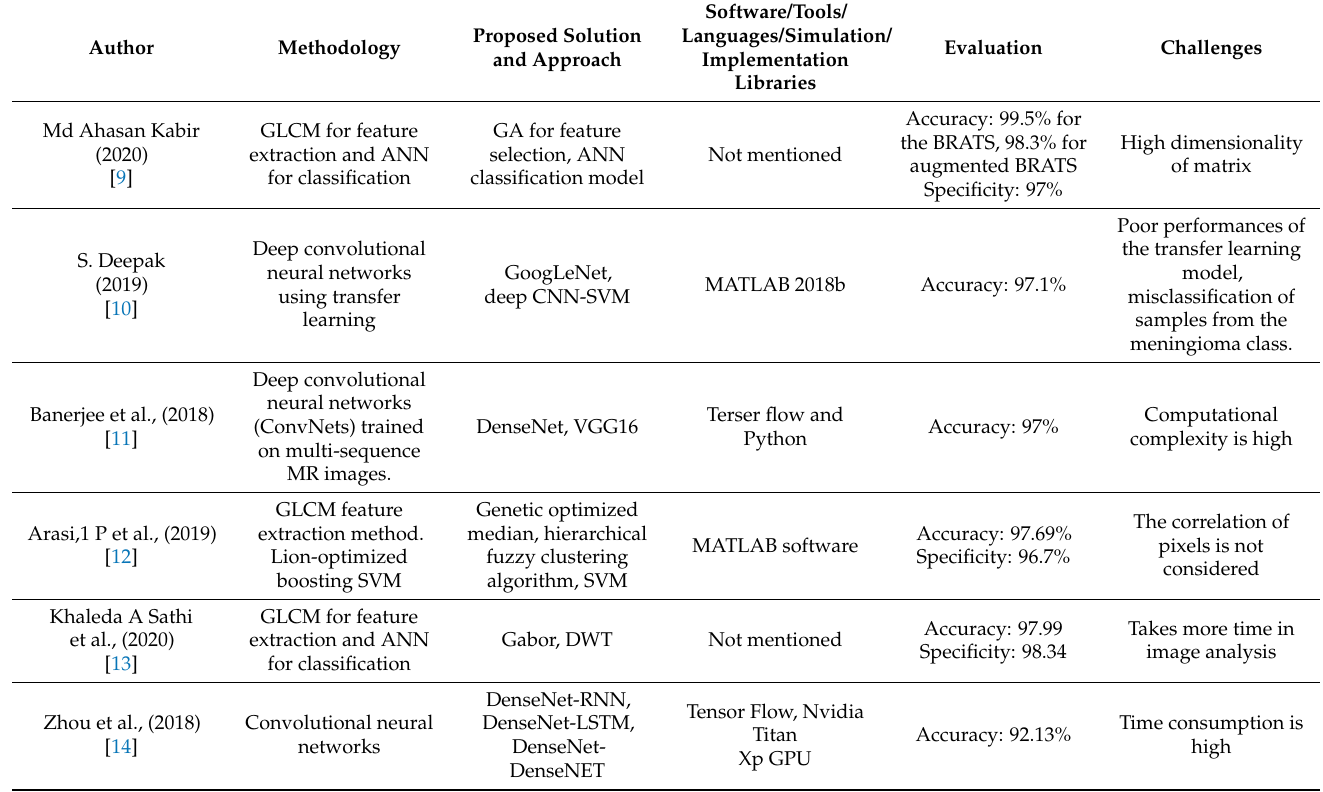
Table 1. Overview of recent work using CNN method used for tumors